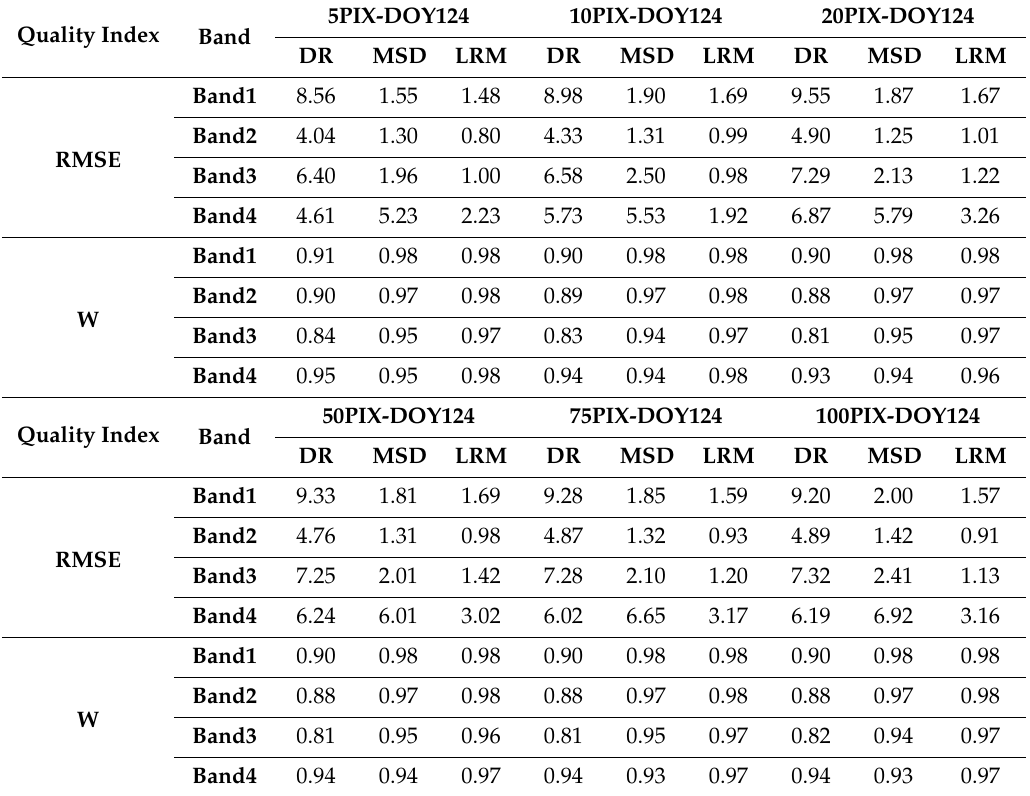
Table 3. Accuracy of cloud removal over six sizes of patches assumed to be cloudy using the reference image captured on DOY 124 for the TM image in the mountainous area of